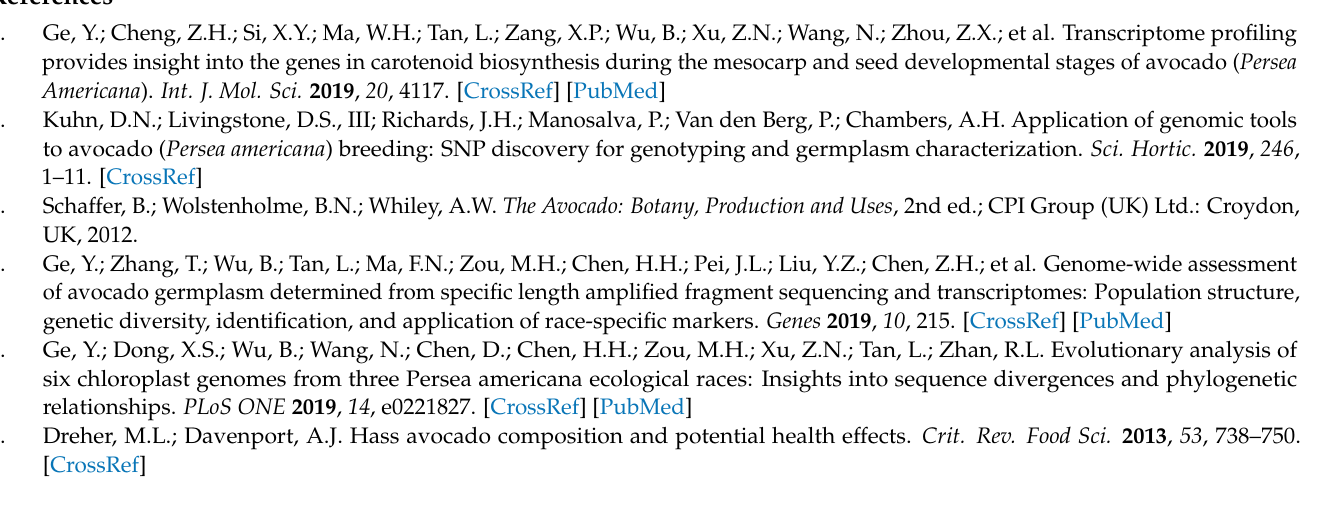
Table S4: Differentially accumulated lipids in pairwise comparison among three avocado ecotypes; Table S5: Metabolite data measured in three avocado ecotypes; Table S6: Differentially accumulated metabolites in pairwise comparison among three avocado ecotypes; Figure S1: PCA scores plot for Mexican ecotype (Walter Hole) (red circle), Guatemalan ecotype (Nabal) (purple diamond), and West Indian ecotype (Donnie) (blue square); Figure S2: PCA scores plot for Mexican ecotype (Walter Hole) (red circle), Guatemalan ecotype (Nabal) (purple diamond), and West Indian ecotype